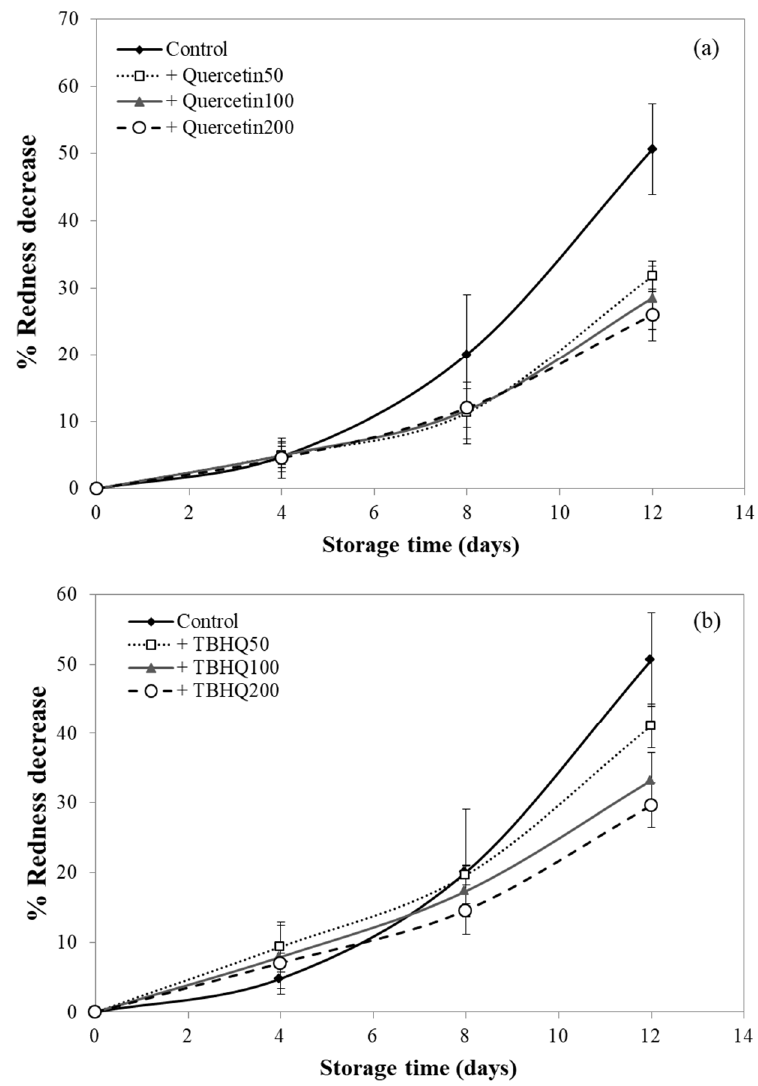
Figure 8. Redness decrease (%) of pork uncovered (control) and covered with cassava starch–CMC film containing ( a ) quercetin and ( b ) TBHQ.